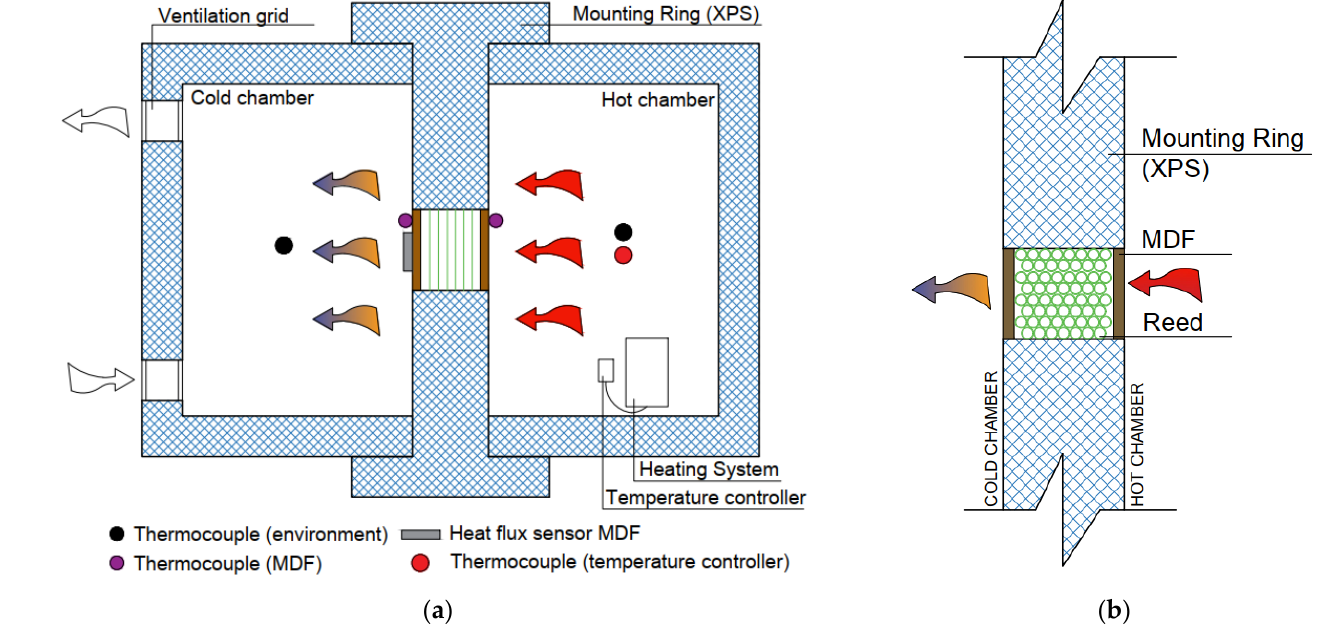
Figure 4. Hotbox components and setup used for giant-reed board tests: ( a ) hotbox horizontal view; ( b ) mounting ring vertical view.